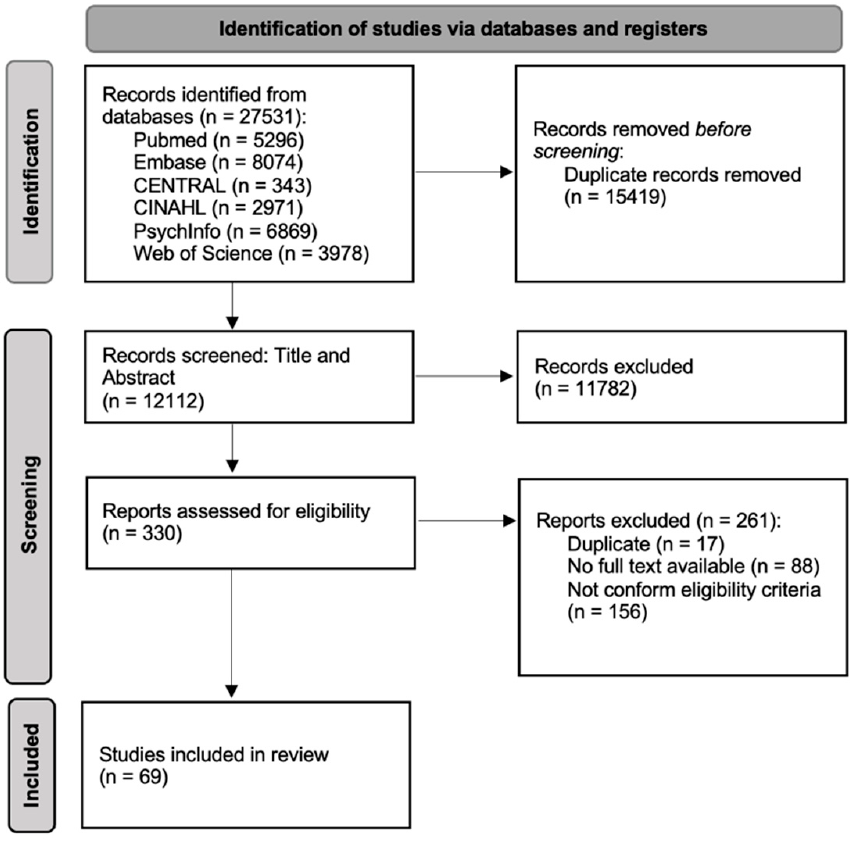
Figure 1. PRISMA flowchart of the article selection.